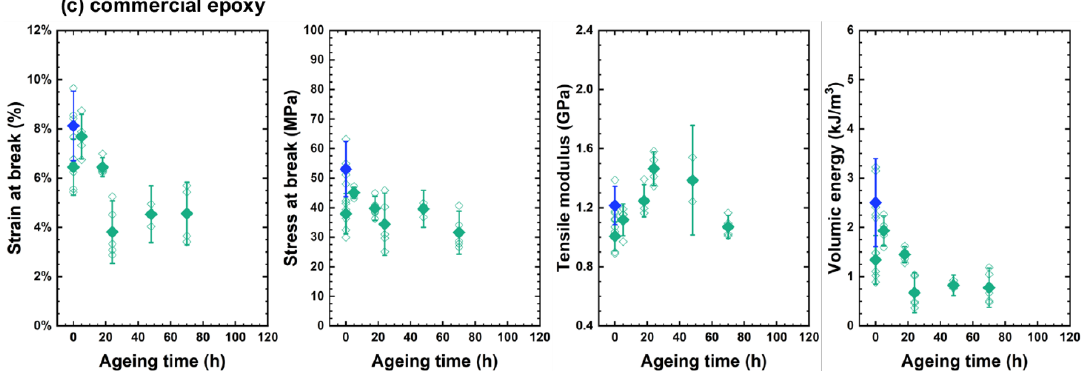
Figure 6. Changes in mechanical properties vs. time for DGEBA-EDA and DGEBA-DETA ( a ), DGEBA-TTDA ( b ) and commercial epoxy ( c ).